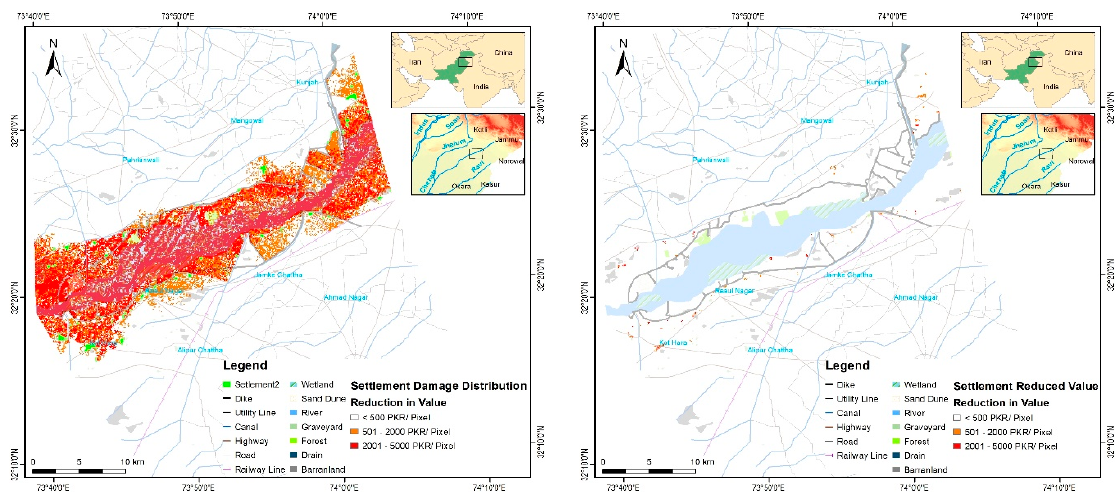
Figure 10. Combined risk map for buildings and households, showed on the left, while the right map shows the damage to the existing settlements.